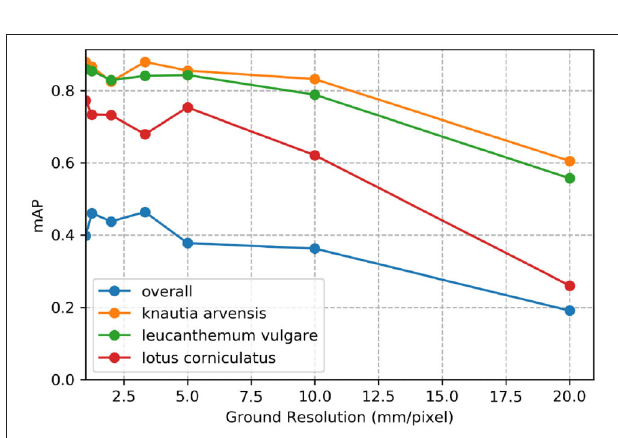
FIGURE 9 | Evolution of the mean average precision (mAP) over various simulated ground